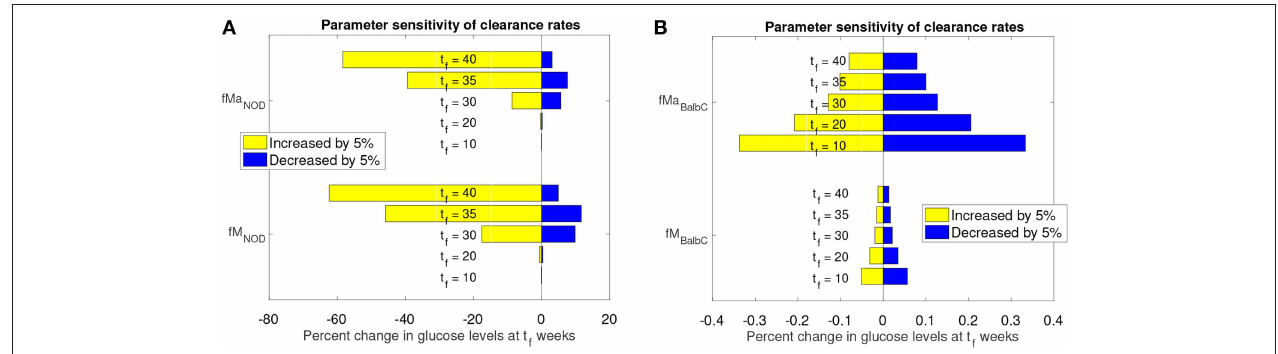
FIGURE 6 | Sensitivity analysis of clearance rates f M and f Ma for NOD and Balb/c mouse models. (A) Effect of 5 % clearance rate changes for the NOD mouse on glucose levels at different weeks, t f . (B) Effect of 5 % clearance rate changes for the Balb/c mouse on glucose levels at different weeks, t f